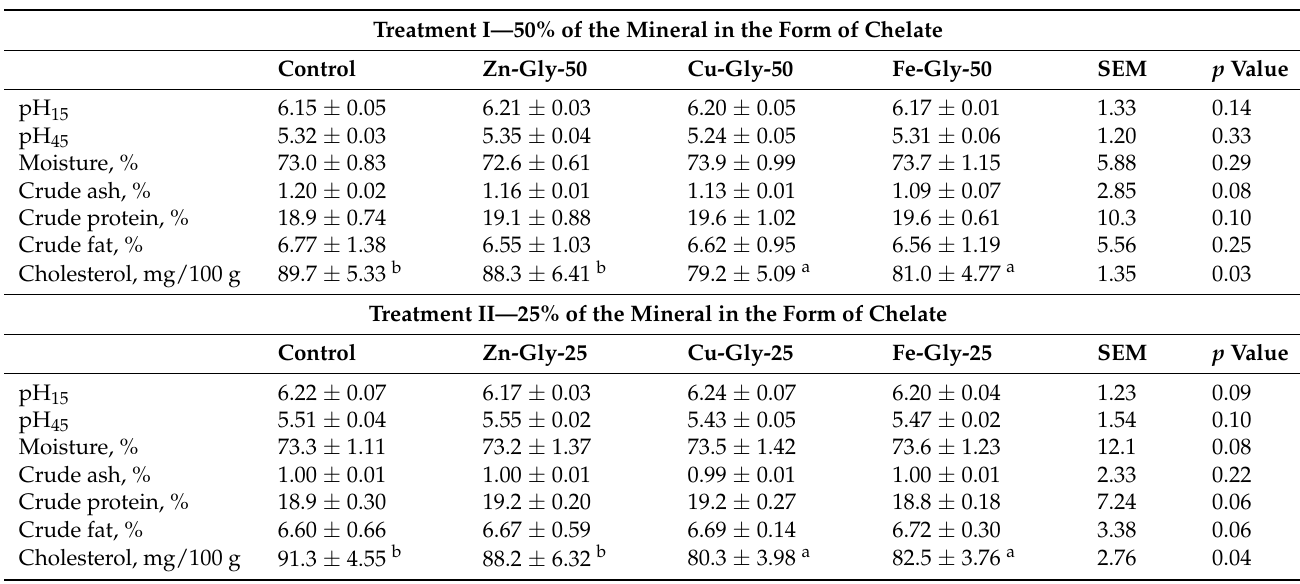
Table 4. The meat pH and chemical composition of thigh-meat